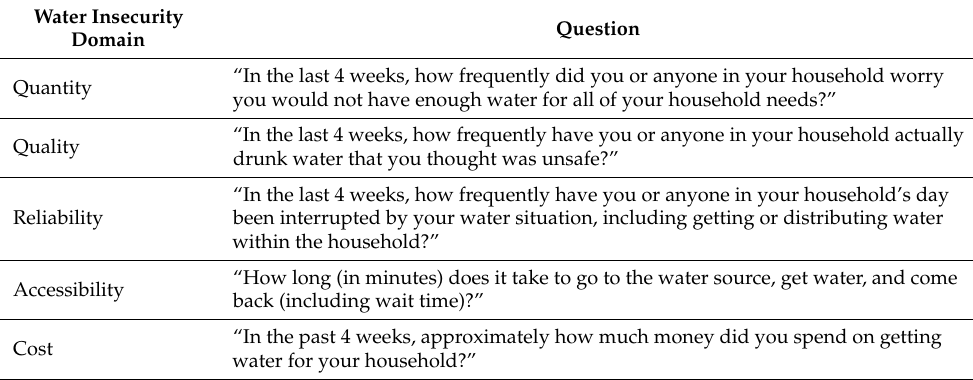
Table 1. Water insecurity domains and survey